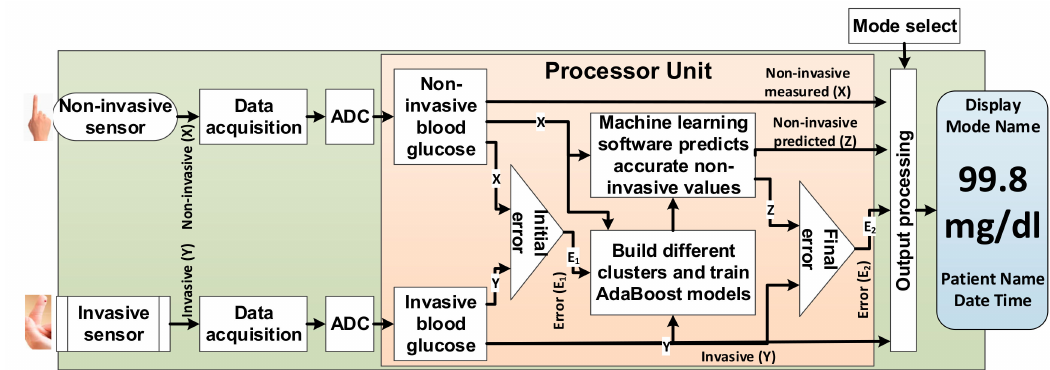
Figure 2. Personalized glucose monitoring system (PGMS) structural